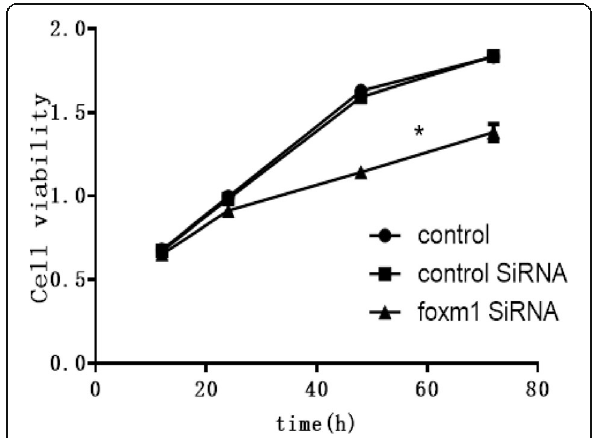
Fig. 5 CCK-8 assays across the three groups at 12 h, 24 h, 48 h and 72 h after FoxM1 silencing. * P <0.05 vs